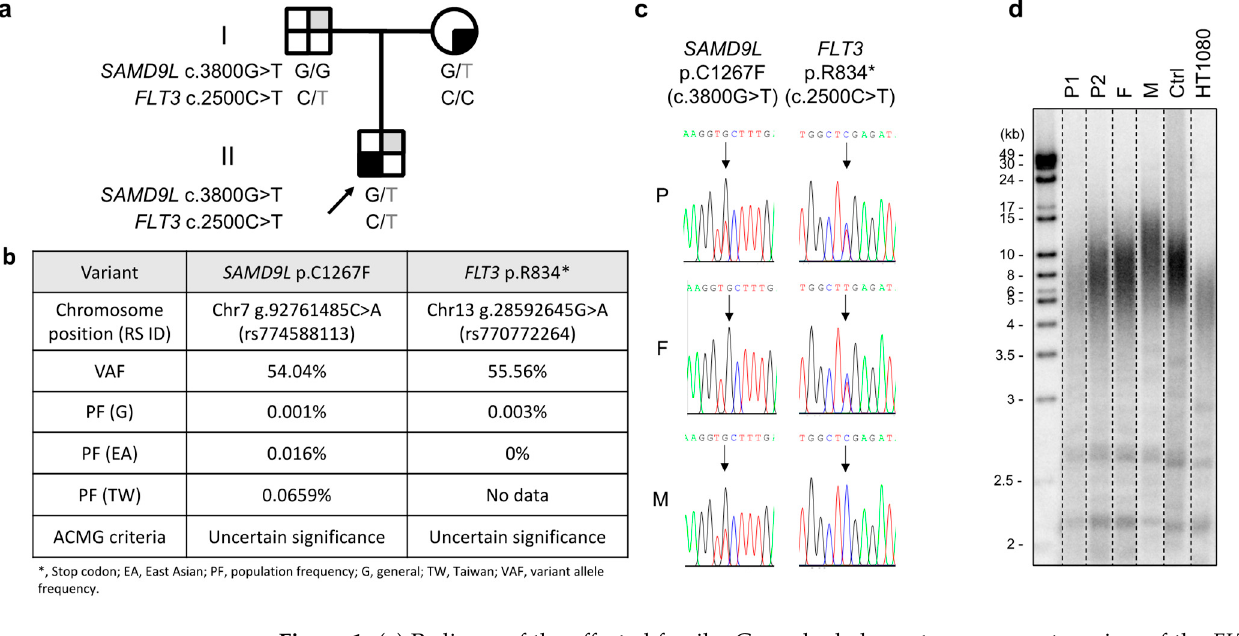
Figure 1. ( a ) Pedigree of the affected family. Gray-shaded quarters represent carriers of the FLT3 c.2500C>T mutation, and black-shaded quarters represent carriers of the SAMD9L c.3800G>T muta- tion. Squares and circle represent male and female subjects, respectively. ( b ) Characteristics of the var- iants. American College of Medical Genetics and Genomics (ACMG) criteria for variant interpretation encompass a five-tier classification: Pathogenic, Likely pathogenic, Uncertain significance, Likely be- nign, and Benign. ( c ) Sanger DNA sequencing of SAMD9L exon 5 on chromosome 7 and FLT3 exon 20 on chromosome 13 from peripheral blood cells taken from subjects of the studied pedigree. Patient (P), patient’s father (F), patient’s mother (M). ( d ) Telomere length analysis (using terminal restriction frag- ment assay) of DNA from leukocytes of the patient pre-transplant (P1) and 1.5 years post-transplant (P2) as well as from the patient’s father (F), patient’s mother (M), a healthy control (Ctrl), and from HT1080 fibrosarcoma cancer cells. The patient pre-transplant (P1) possessed shorter and heterogene- patient 1.5 years post-transplant (P2) became more normal and similar to those of his father (F).